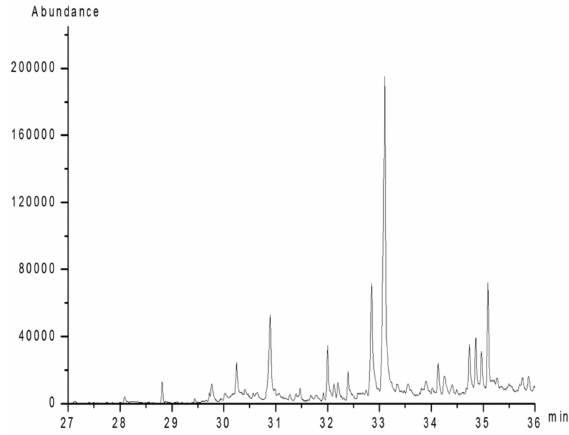
Figure 4. Total ionic chromatogram of methylated PAP-3. Table 2. Results of the methylation of PAP-3 from P. aquilinum